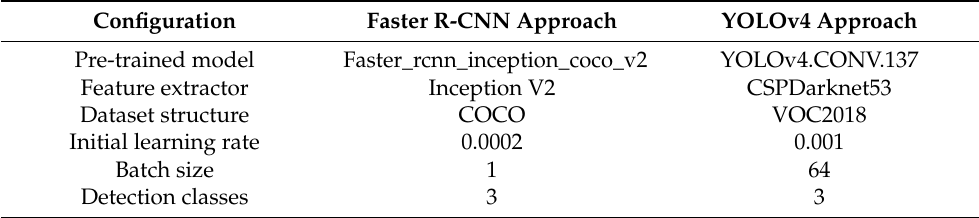
Table 3. Configuration of pre-trained models for the Faster R-CNN and YOLOv4 approaches.